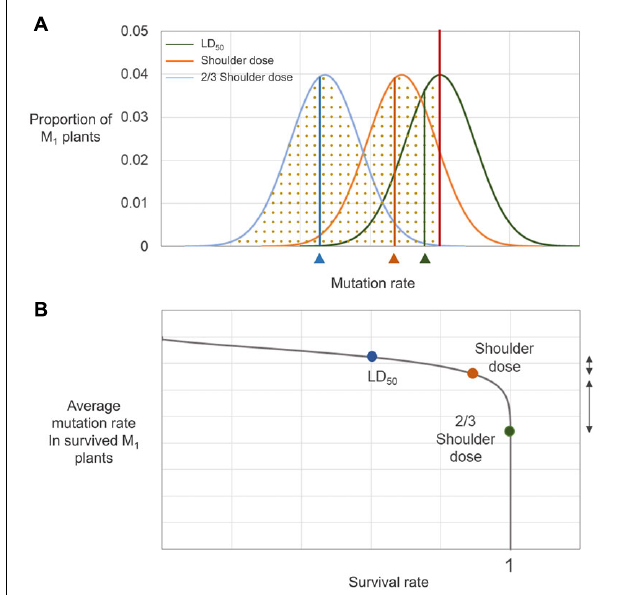
FIGURE 9 | Hypothesized relationship between survival rate and mutation rate. (A) Distribution of irradiated individuals with different mutation rates. The red vertical line represents the threshold mutation rate that a survived M 1 individual can contain. Green, orange, and blue curves are the probability distribution curves for M 1 plants irradiated at LD 50 , shoulder dose, and two-thirds of shoulder dose, respectively. Dotted regions below each graph indicate the survival rate of individuals irradiated at each dose. The vertical lines on each graph indicates the average mutation rate of the survived individuals for each irradiation treatment. (B) Relationship between survival rate and mutation rate derived from (A) . The dots represent survival rate and average mutation rate of survived plants determined from (A) . The direction arrows on the right side of the graph indicate differences in mutation rate between LD 50 and shoulder dose-irradiated individuals (shorter arrow) and between shoulder dose and two-thirds of shoulder dose-irradiated individuals (longer